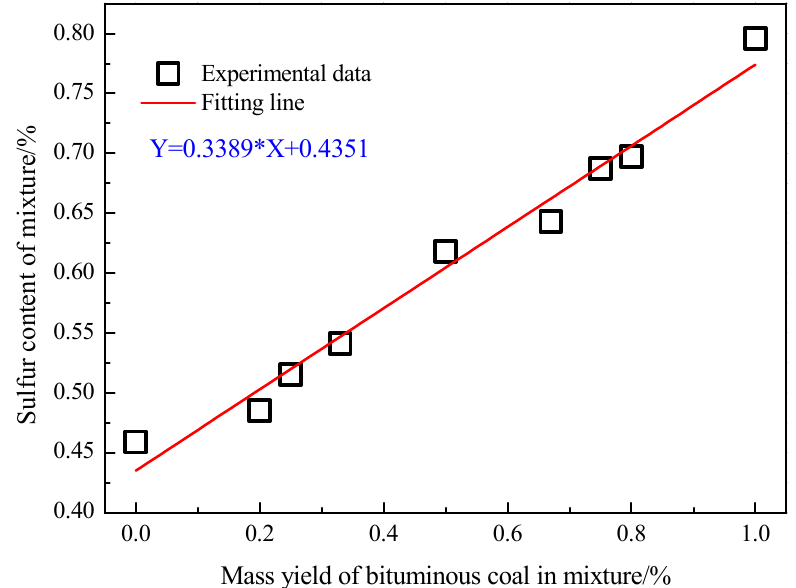
Figure 2. Relation between sulfur content of mixture and mass yield of bituminous coal.